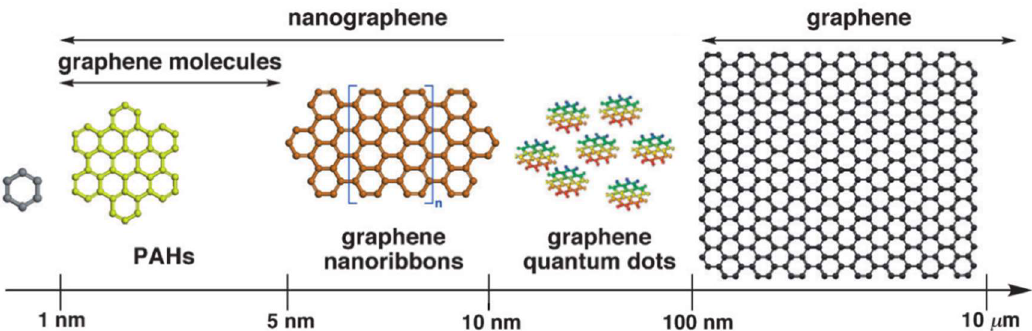
Figure 1. Schematic illustration of 2D graphene film defined according to their size scale. Reproduced from [22] (PAHs, graphene and graphene nanoribbons), with permission from Wiley, 2012. Reproduced from [29] (GQD), with permission from The Royal Society of Chemistry, 2012.